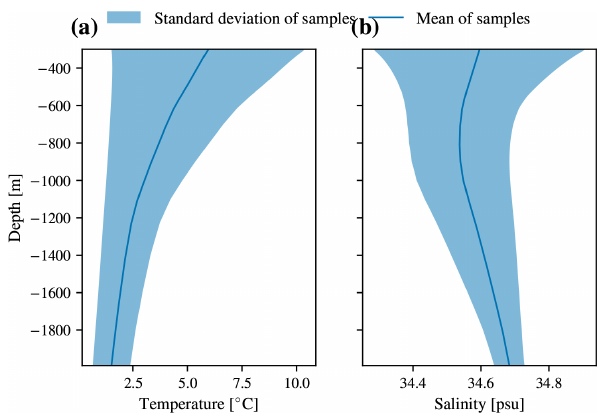
Figure B1. The means and standard deviation of samples taken from B-SOSE iteration 106.